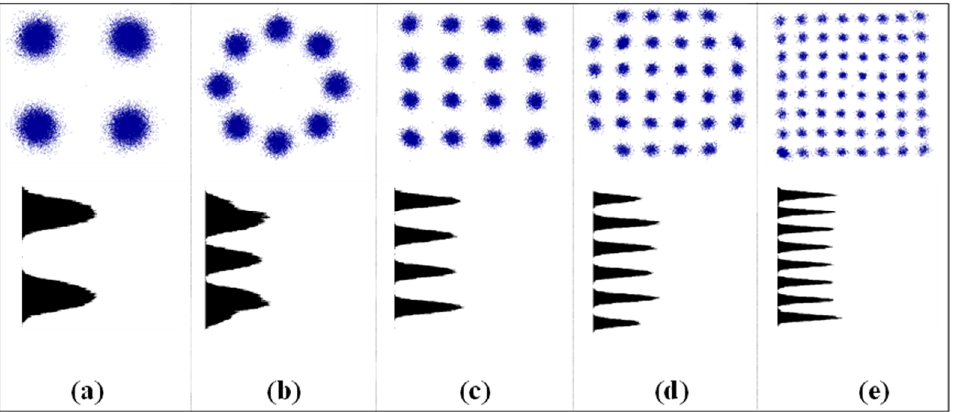
Figure 1. Samples of the constellation and horizontal projection for all modulation formats at OSNR = 25 dB. ( a ) QPSK, ( b ) 8PSK, ( c ) 16QAM, ( d ) 32QAM, and ( e ) 64QAM.